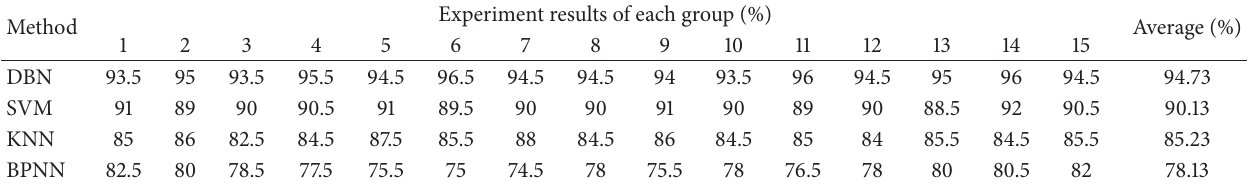
Table 6: Results of testing